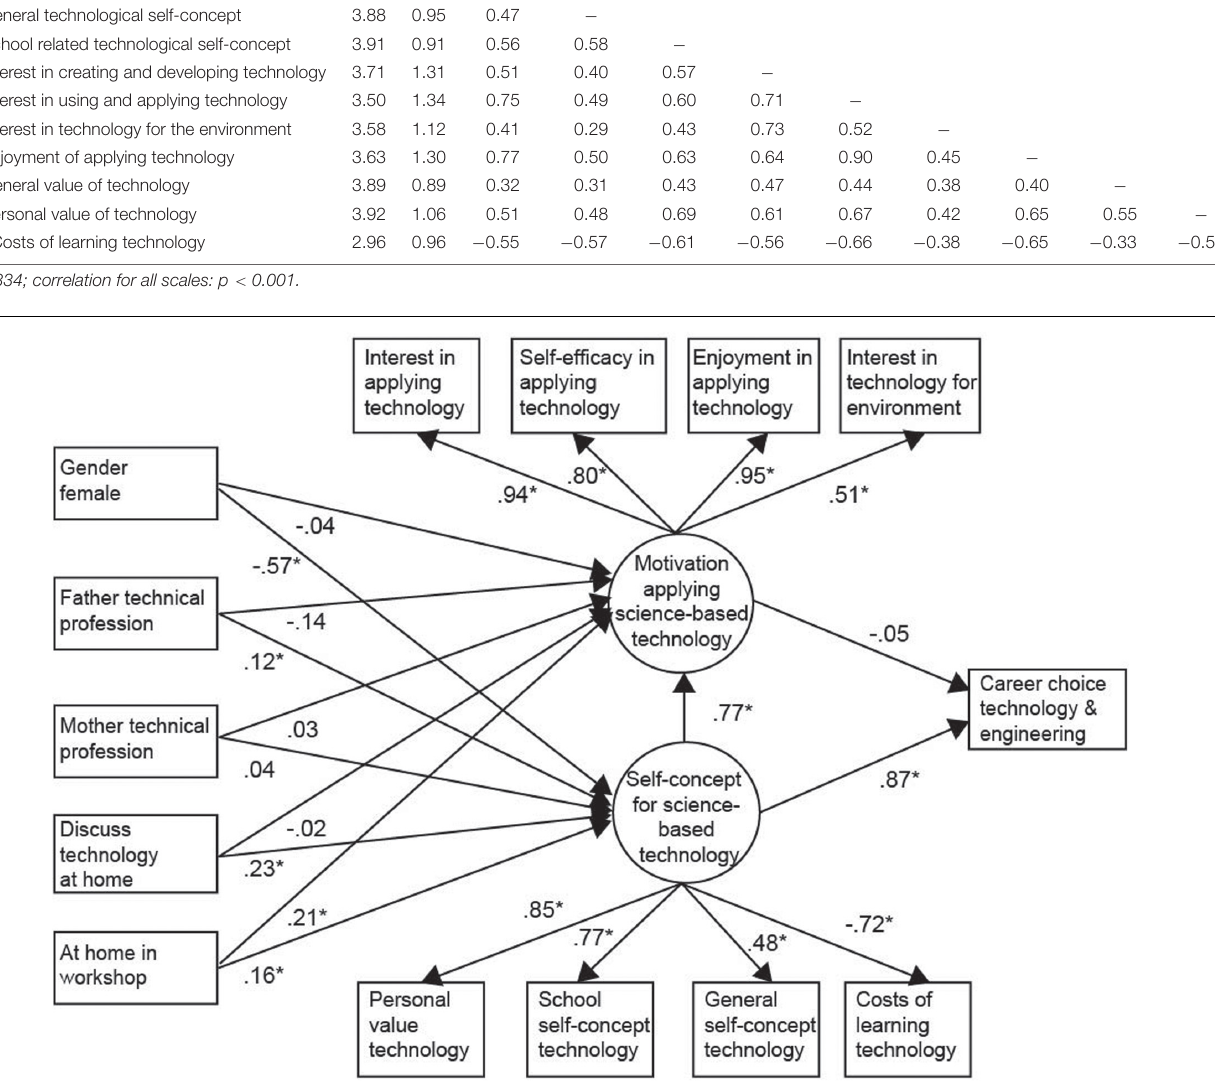
FIGURE 3 | Structural equation model of secondary students’ career preferences for technology and engineering professions. Note: N = 321; *all paths p < 0.05, estimates are